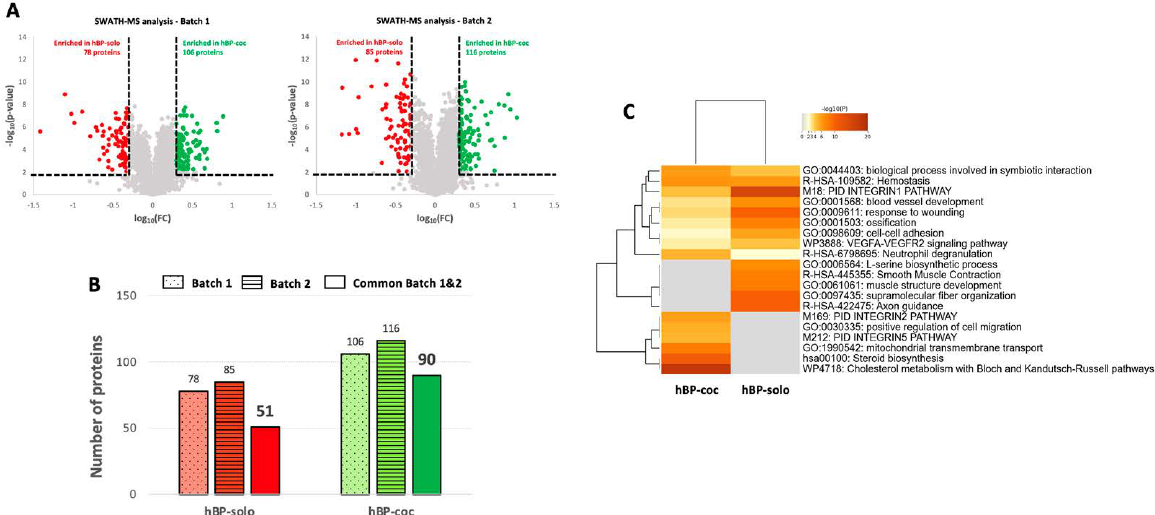
Figure 3. SWATH quantification of proteins enriched in hBP-solo and hBP-coc. ( A ) Volcano plots from the two independent batches used for the study. Inclusion criteria to point out significant candidates: log10(Fold Change) > 0.3 for hBP-coc enriched proteins (FC > 2); log10(FC) < 0.3 for hBP-solo enriched proteins (FC < 2); − log10( p -value) < 0.01 for the selected proteins in both conditions ( p -value < 0.01). ( B ) Number of significant enriched protein in hBP-solo and hBP-coc from the 2 independent batches and common between the two batches. The reduced number of proteins in this common pool corresponds to the mean of SWATH quantification between Batch 1 and Batch 2 with FC > 2. ( C ) Dendogram of statistically enriched ontology clusters for significant hBP-solo and hBP-coc enriched proteins. − log10( p -values) represents the enrichment of protein candidates in each cluster.